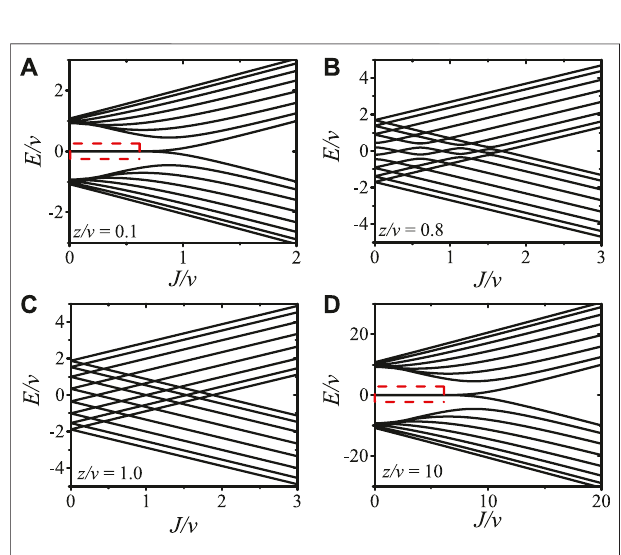
FIGURE 5 | (Color online) Energy spectrum of the open chain optomechanical array for N (cid:1) 8 as a function the intracell hopping amplitude J for different intercell hopping amplitude z : (A) z / v (cid:1) 0.1; (B) z / v (cid:1) 0.8; (C) z / v (cid:1) 1.0; (D) z / v (cid:1) 10. The phase factor is ϕ (cid:1)